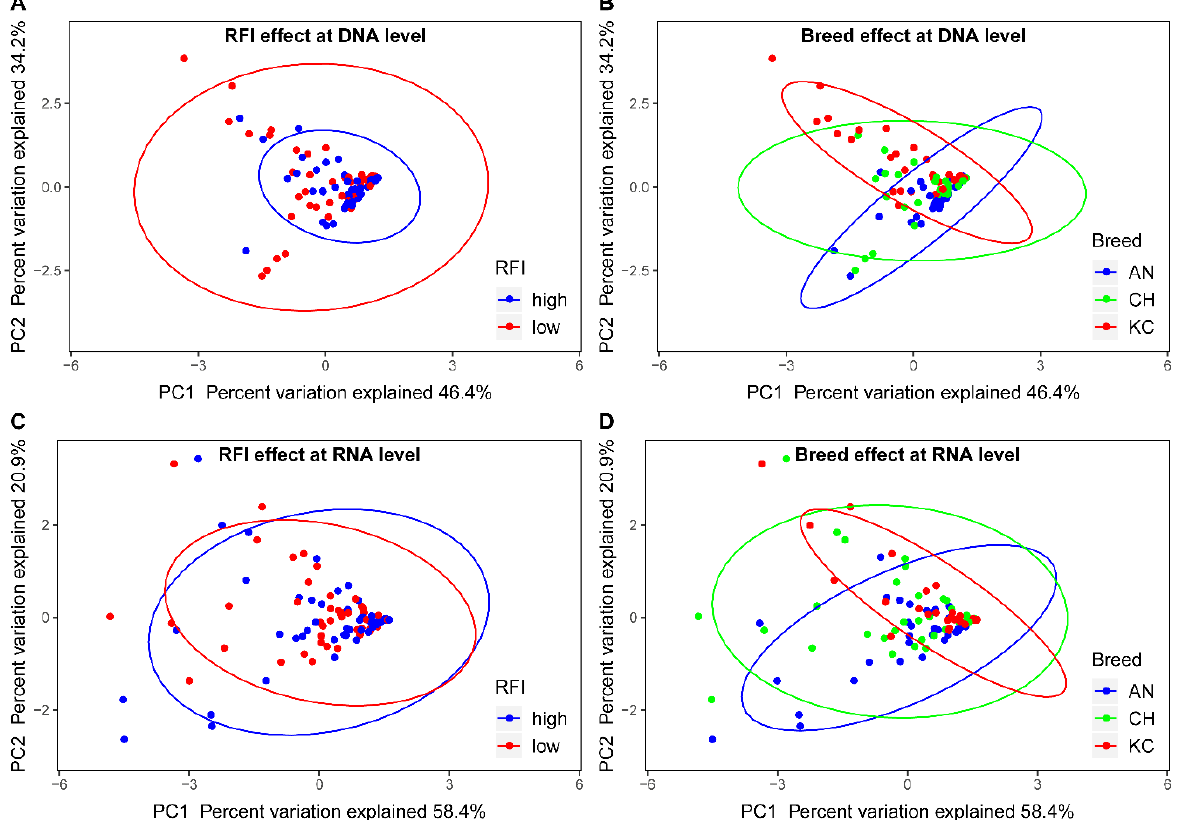
Figure 1. The similarity in rumen microbiota profiles for steers of either a different breed (AN: angus; CH: Charolais; KC: crossbred Kinsella composite) or with divergent RFI (high and low). PCA analysis was conducted on absolute copies of the targeted microbial groups at either the DNA ( A , B ) or RNA ( C , D ) level. The ovals in the plot are 95% inertia ellipses. Specifically, as showed in Table 3, the protozoal abundance in the rumen of AN steers was 1.74 × 10 8 (8.24 log) copies of 18 S rRNA gene per gram of rumen content, 1.20 × 10 9 (9.08 log) and 7.24 × 10 8 (8.86 log) copies of 18 S rRNA gene per gram